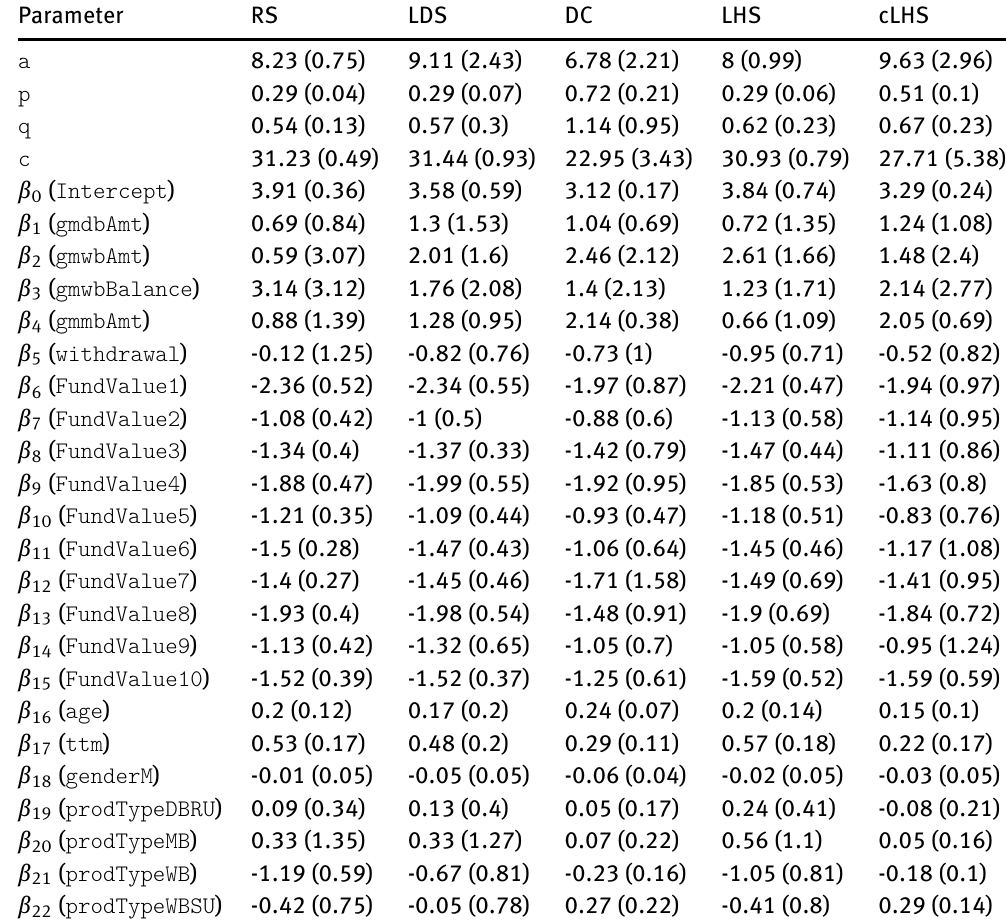
Table 5: The average and standard deviation of the estimated parameters of the GB2 model over 10 runs when s = 220 . Parameter